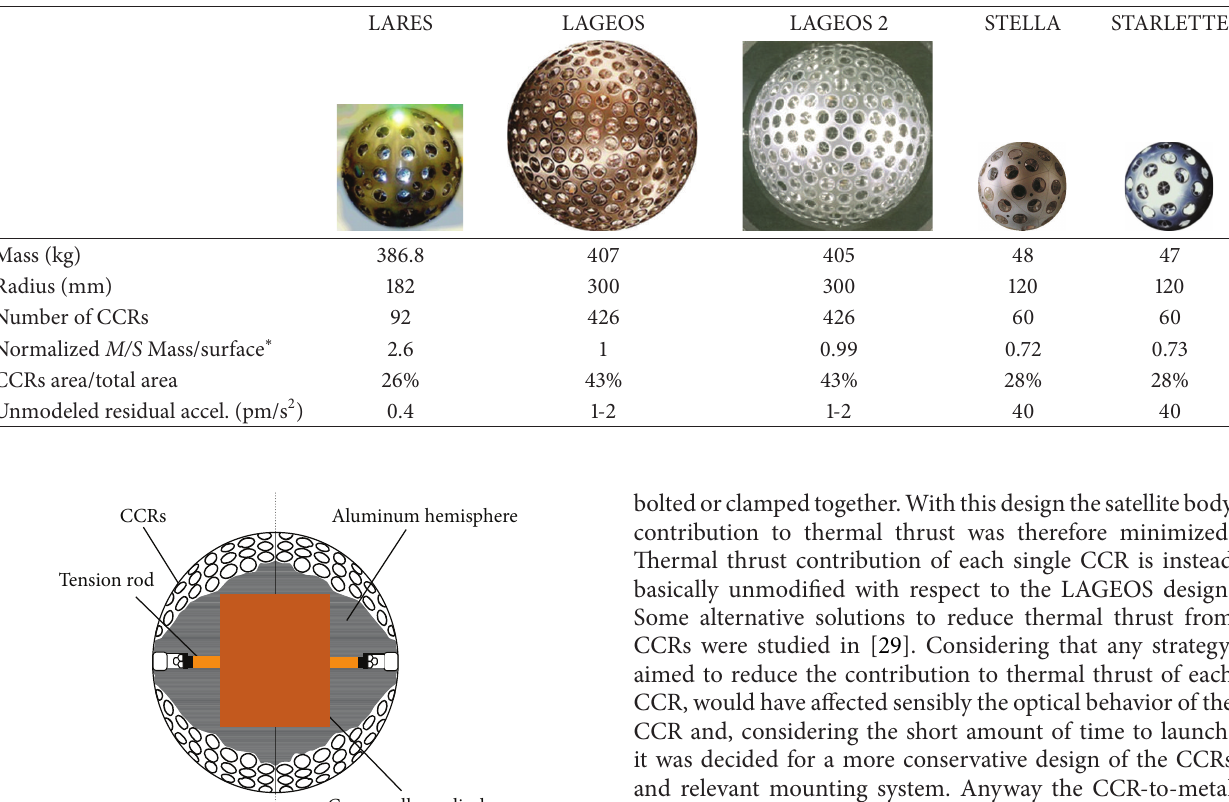
Table 2: Characteristics of laser ranged satellites. ∗ ( M/S ) respect to that of LAGEOS.